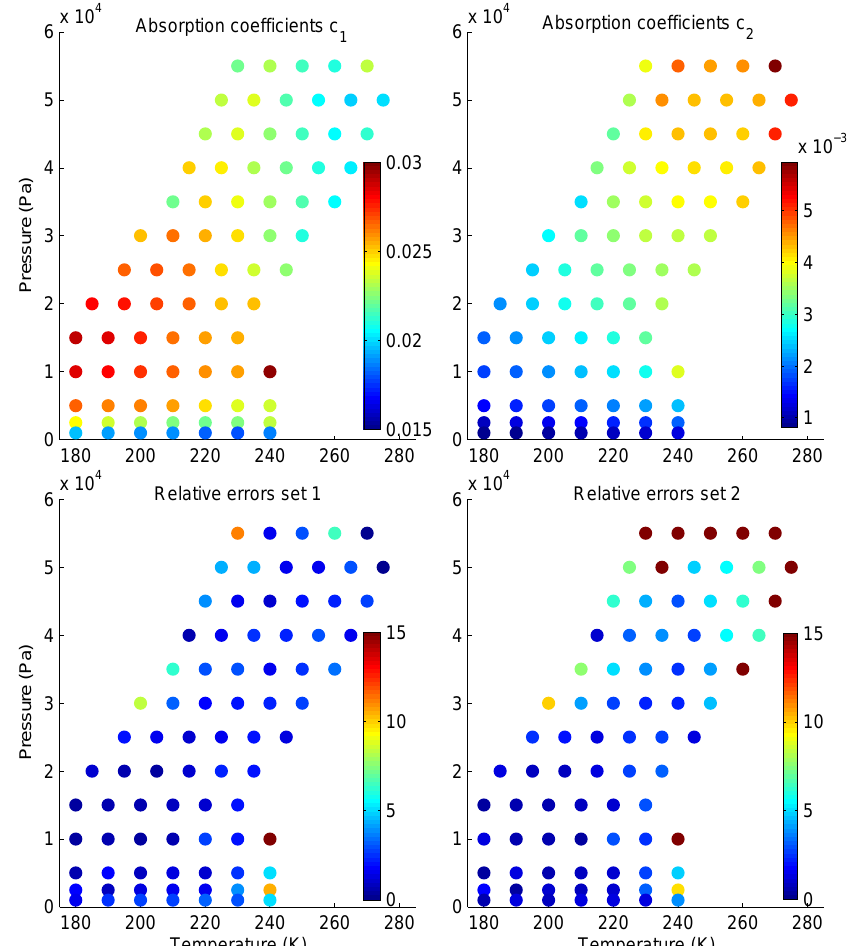
Fig. 5. Absorption coefficients for the two sets of IASI channels (top) and their corresponding average errors in percentage (bottom). Here the absorption coefficients and errors are shown for a SO 2 cloud of 10DU (set 1) and 750DU (set 2)